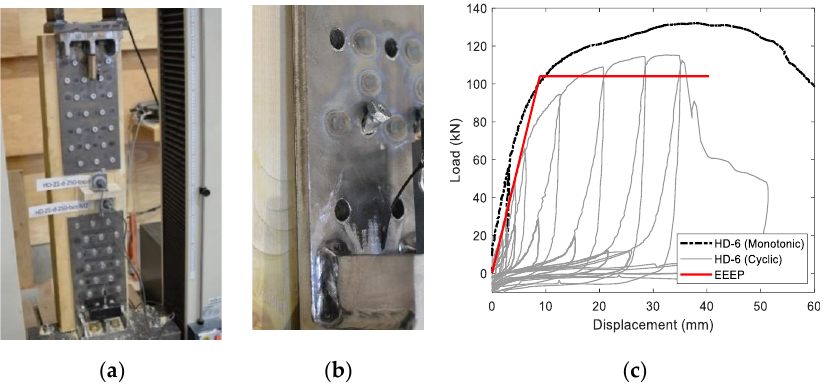
Figure 11. ( a ) HD with STS; ( b ) failure mode (photo credit: Thomas Tannert); ( c ) force – displacement curves.